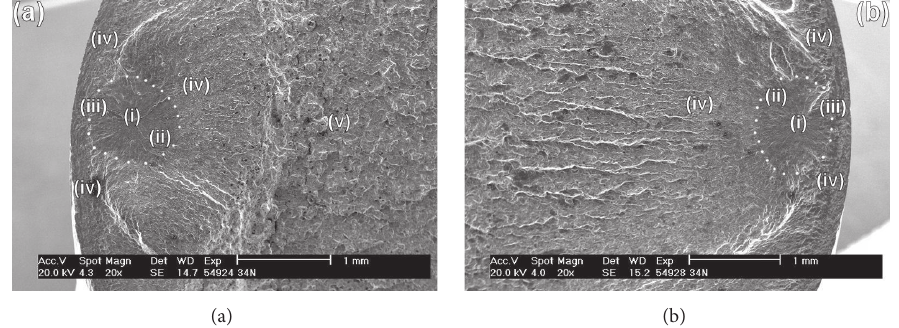
Figure 1: Initiation sites in nitrided steel specimen subjected to combined bending-torsion loading ( 𝑍 = 0.63 , 𝑁 𝑓 = 2.0 × 10 5 cycles) with the failure sequence phases marked in images.